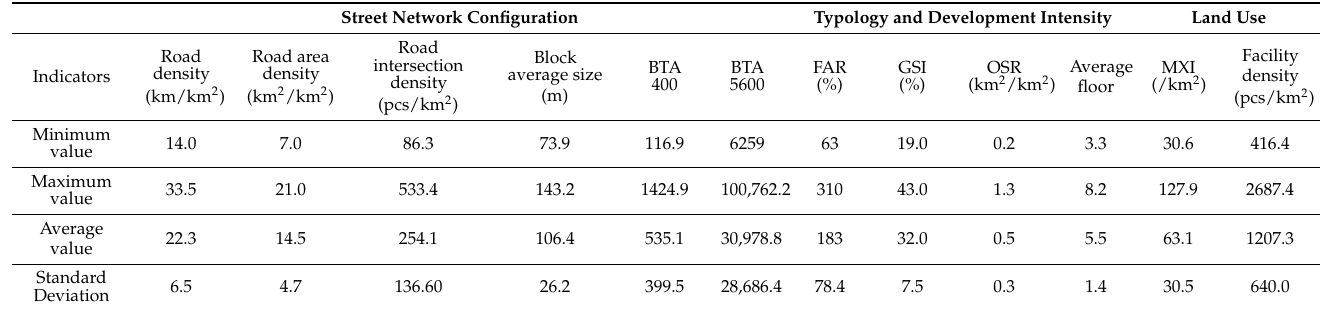
Table 3. Quantitative analysis summary.